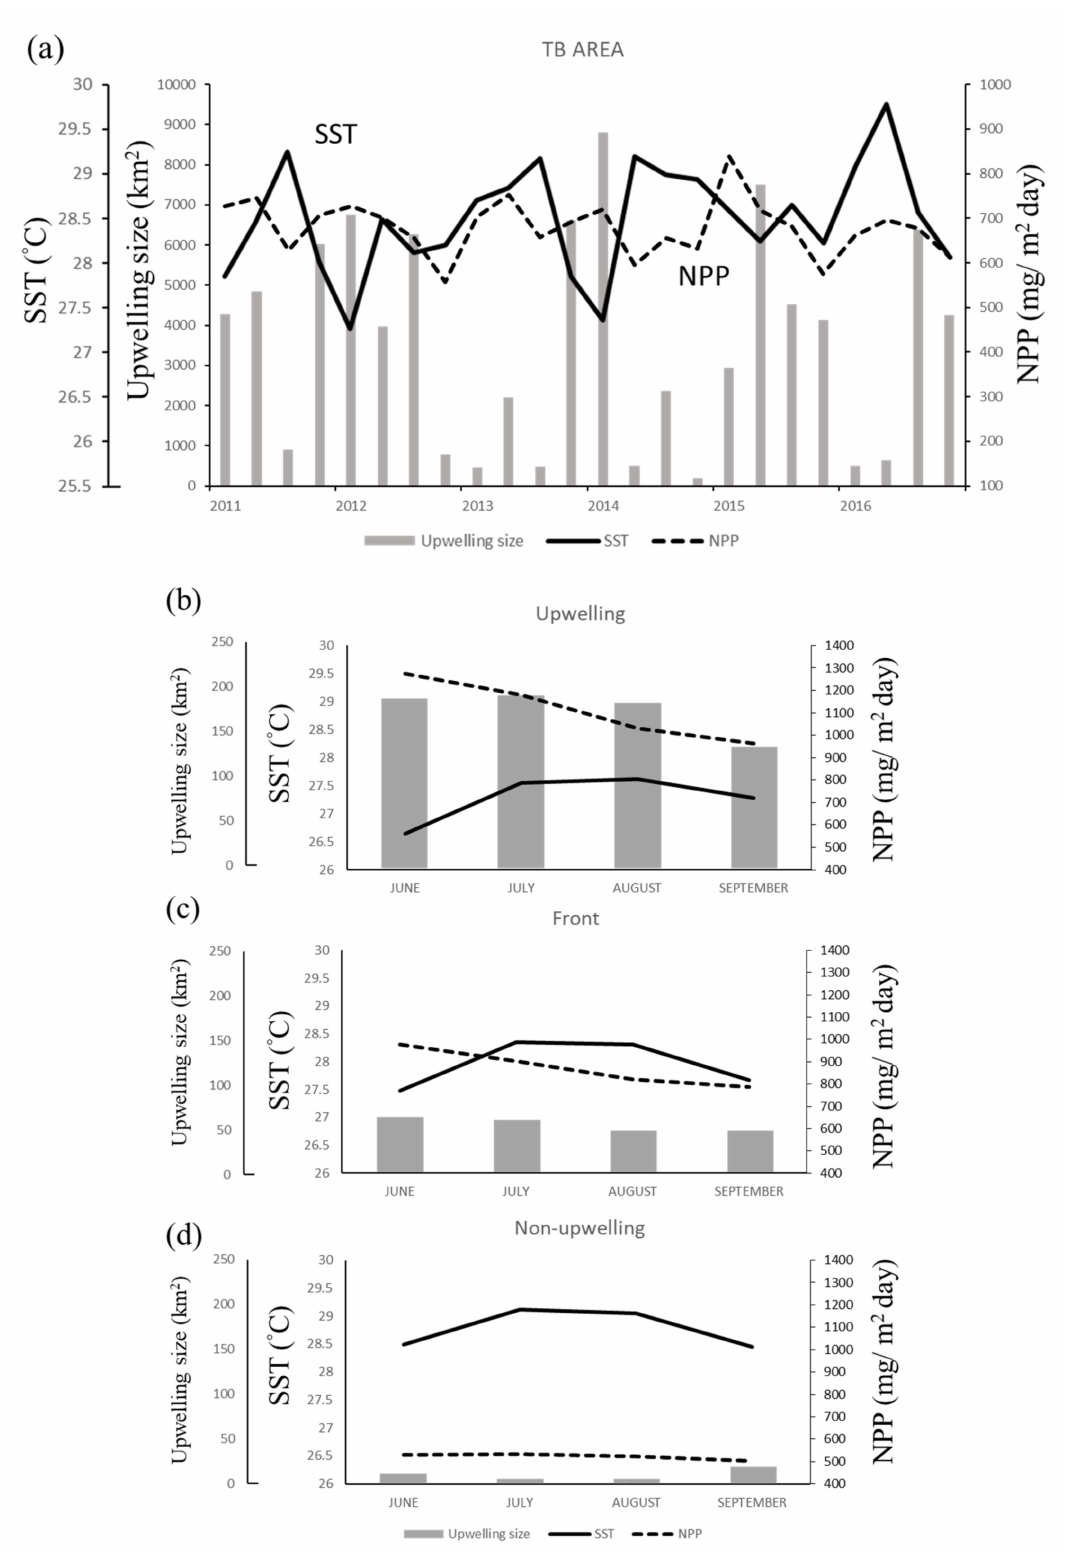
Figure 4. Time series showing the relationship of sea surface temperature (SST) with net primary production (NPP) and upwelling size in ( a ) the Taiwan Bank (TB) region, ( b ) upwelling habitat, ( c ) thermal front habitat, and ( d ) non-upwelling habitat. Monthly data are presented in ( b – d